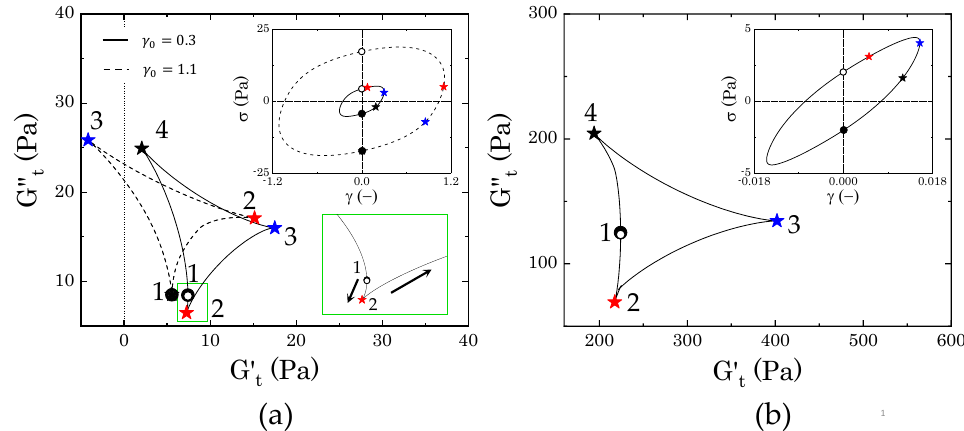
Figure 13. ( a ) Cole-Cole plot obtained at γ 0 = 0.3 (solid line) and 1.1 (dashed line) (local minimum of G (cid:48)(cid:48) and second peak of G (cid:48)(cid:48) , respectively) for sample M0 at 0.9% wt of Carbopol; ( b ) Cole–Cole plot obtained at γ 0 = 0.015 (first region of decay of G (cid:48)(cid:48) ) for sample M2 at 0.9% wt of Carbopol. The insets show the corresponding elastic Lissajous–Bowditch plot (i.e., stress vs. strain) for